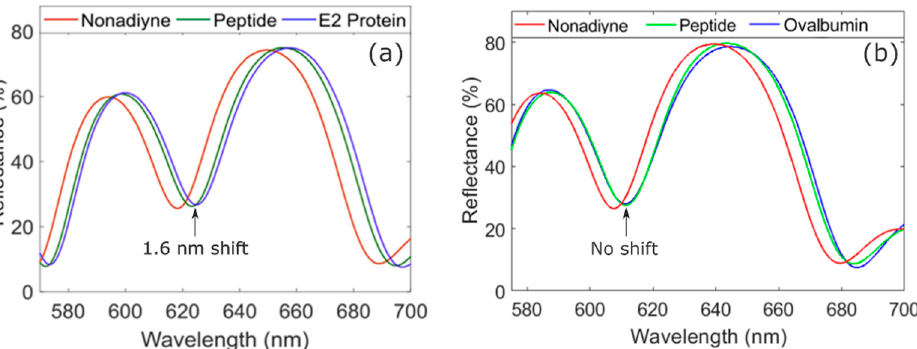
Figure 5. Reflectance measurements from E2 sensing and control experiments. ( a ) Reflectance spectra showing spectral redshift after clicking the peptide capture agent to the alkyne-terminated PSi sensor and an additional 1.6 nm spectral redshift after exposure of the peptide-modified PSi sensor to 1 μ M E2 protein in DI water. The spectral redshifts confirm peptide functionalization and target E2 protein capture and detection. ( b ) Reflectance spectra for control experiment showing spectral redshift after peptide functionalization of the PSi sensor and no spectral shift after exposure of the sensor to 1 μ M non-target chicken ovalbumin in water, which confirms the specificity of the peptide capture agent.